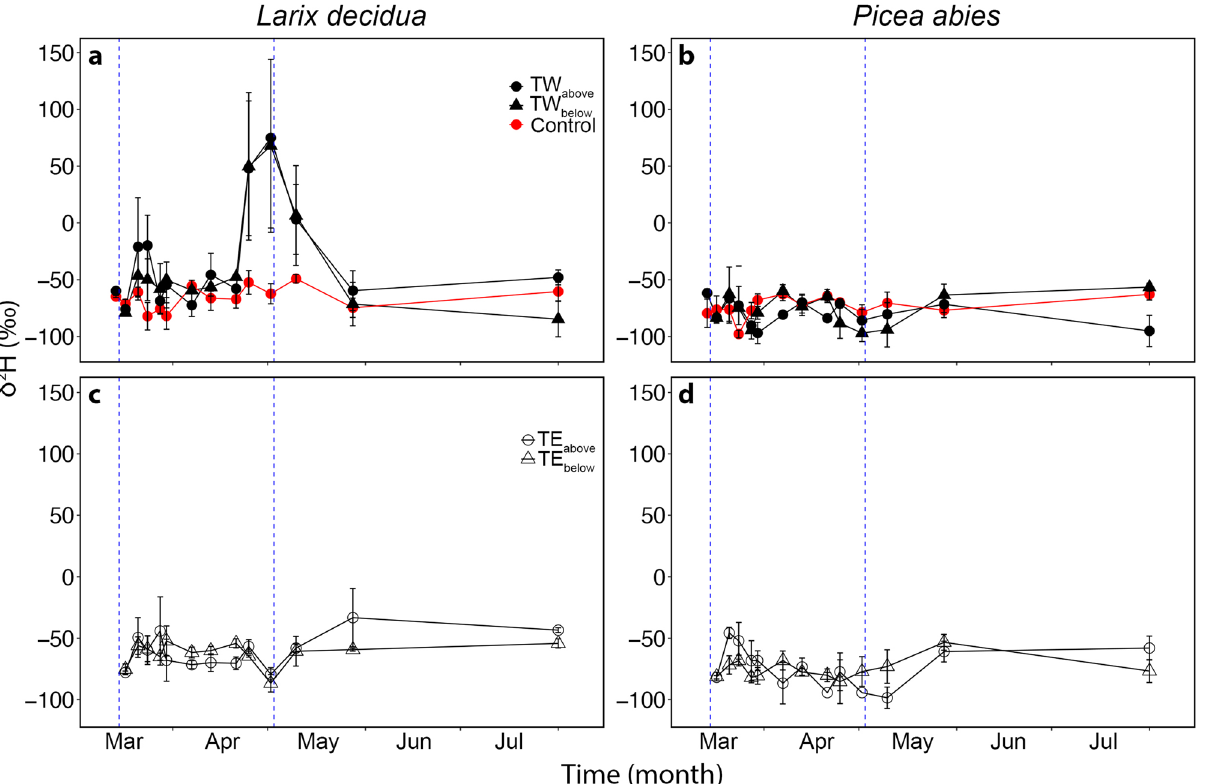
Figure 3. Microcores δ 2 H analyses. δ 2 H analyses (‰) of microcores extracted from the trunk of three L. decidua and three P. abies specimens growing at the alpine treeline during the seasonal course (from 14.03.2017 to 01.08.2017). Panels ( a ) and ( b ) show values from unlabeled specimens (red symbols; breast height and west exposed) and cores collected from the west side of the trunk, 20 cm above (TW above ; full dots) and below (TW below ; full triangles) the labelled branch (see Fig. 1 for sample nomenclature). Panels ( c ) and ( d ) show values from cores collected from the east side of the trunk, 20 cm above (TE above ; open dots) and below (TE below ; open triangles) the labelled branch (see Fig. 1 for sample nomenclature). Mean ± SE. Blue dashed vertical lines indicate the time of bag installation (14.03.2017) and removal